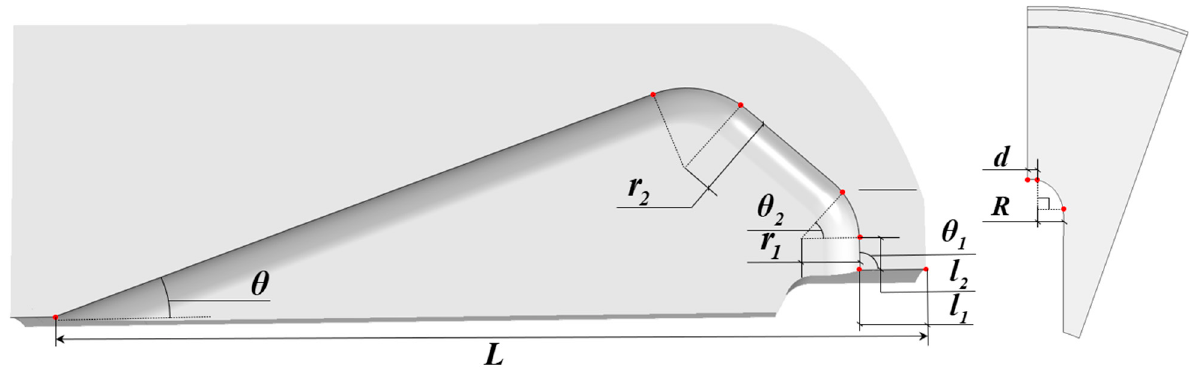
Figure 1. Geometric model of the SRM with finocyl grain.